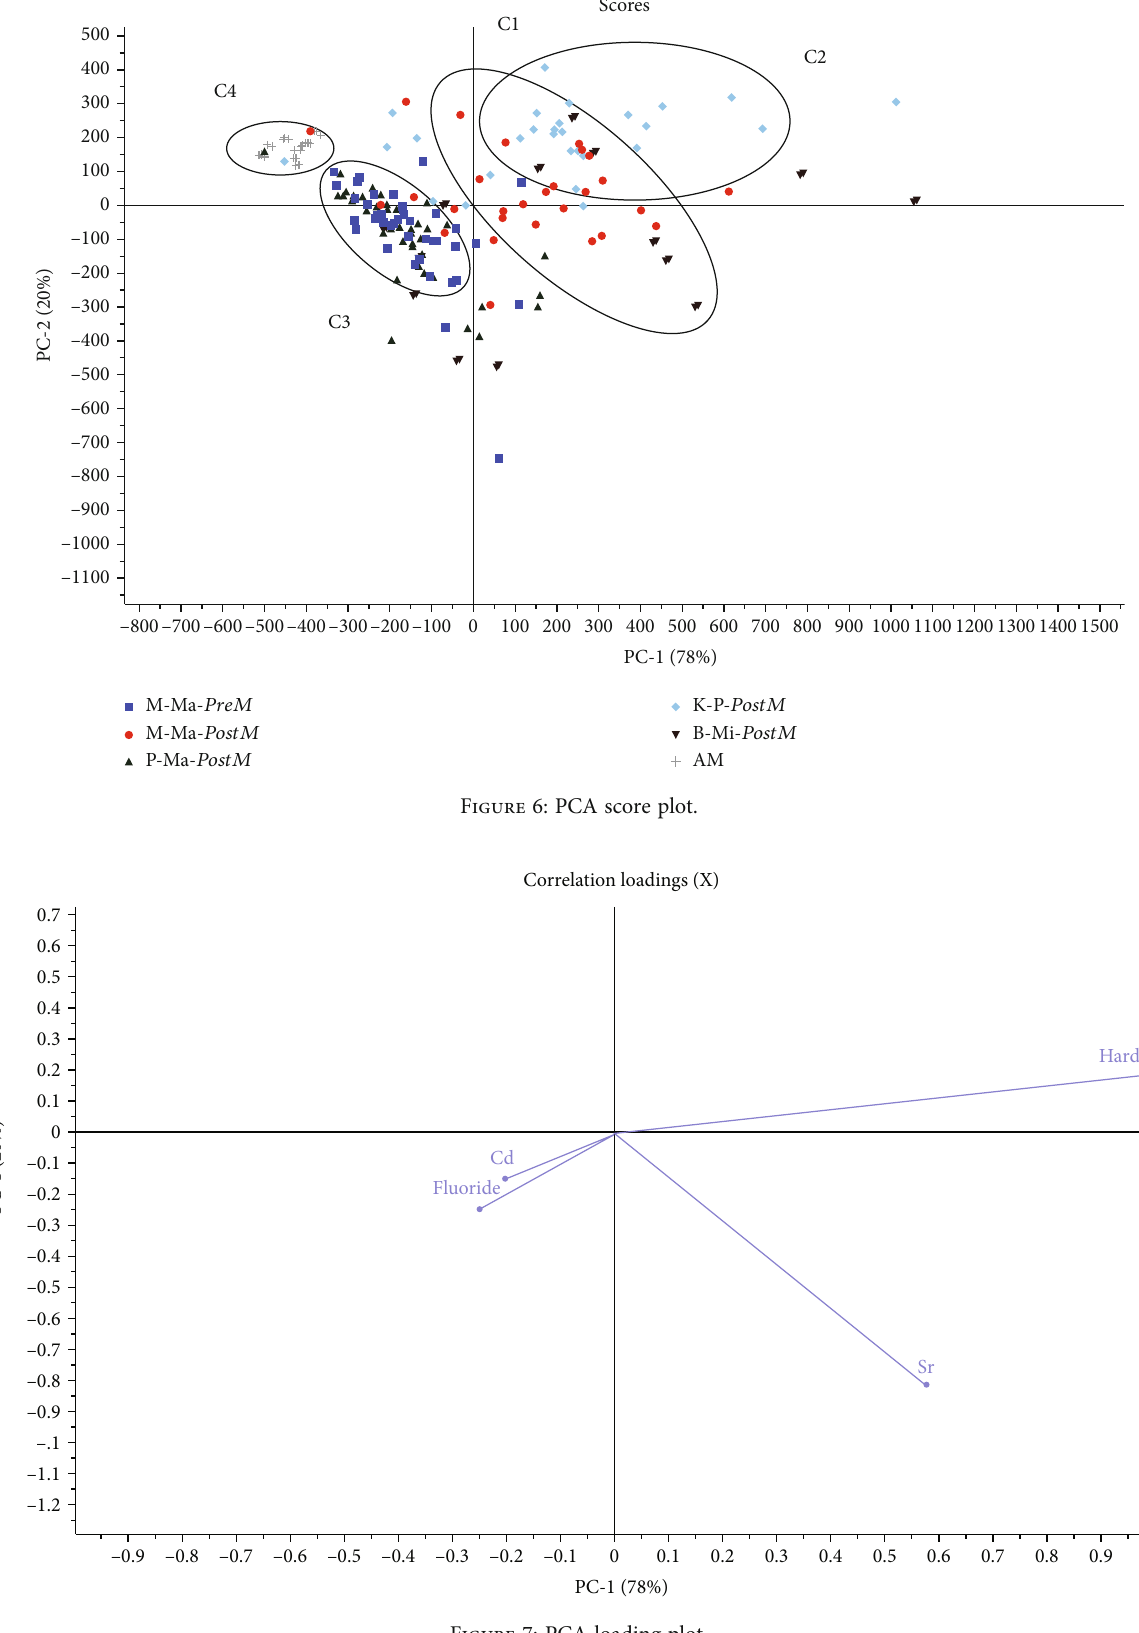
Figure 6: PCA score plot.